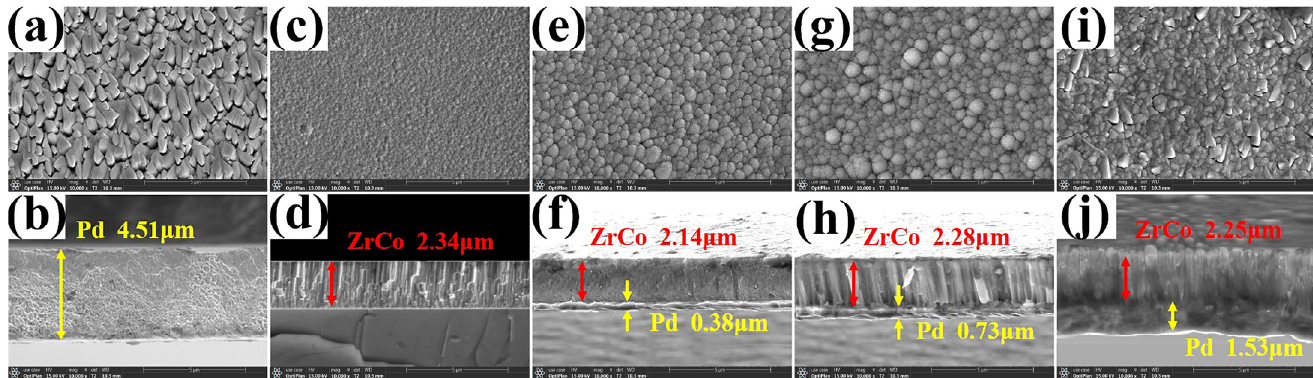
Figure 2. Surface and cross-sectional SEM pictures at a magnification of 10,000×: ( a , b ) Pd; ( c , d ) ZrCo; ( e , f ) 5-Pd/ZrCo; ( g , h )10-Pd/ZrCo; ( i , j ) 20-Pd/ZrCo films. Table 2. The hydrogen absorption capacity, hydrogen absorption time to 95% saturation, and rate constant of the Pd, ZrCo, and Pd/ZrCo films.